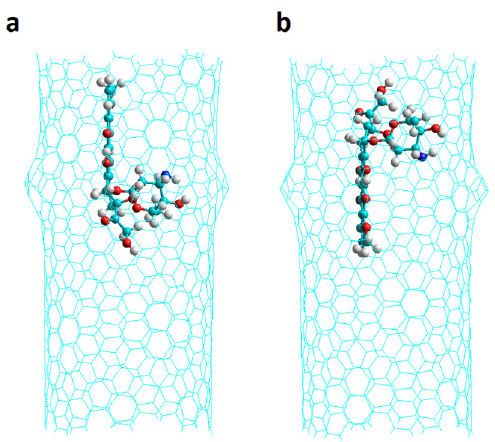
Figure 2. DOX orientation when encapsulated in a chiral nanotube having two haeckelite defects. ( a ) v1 orientation; ( b ) v2 orientation. Lateral views.